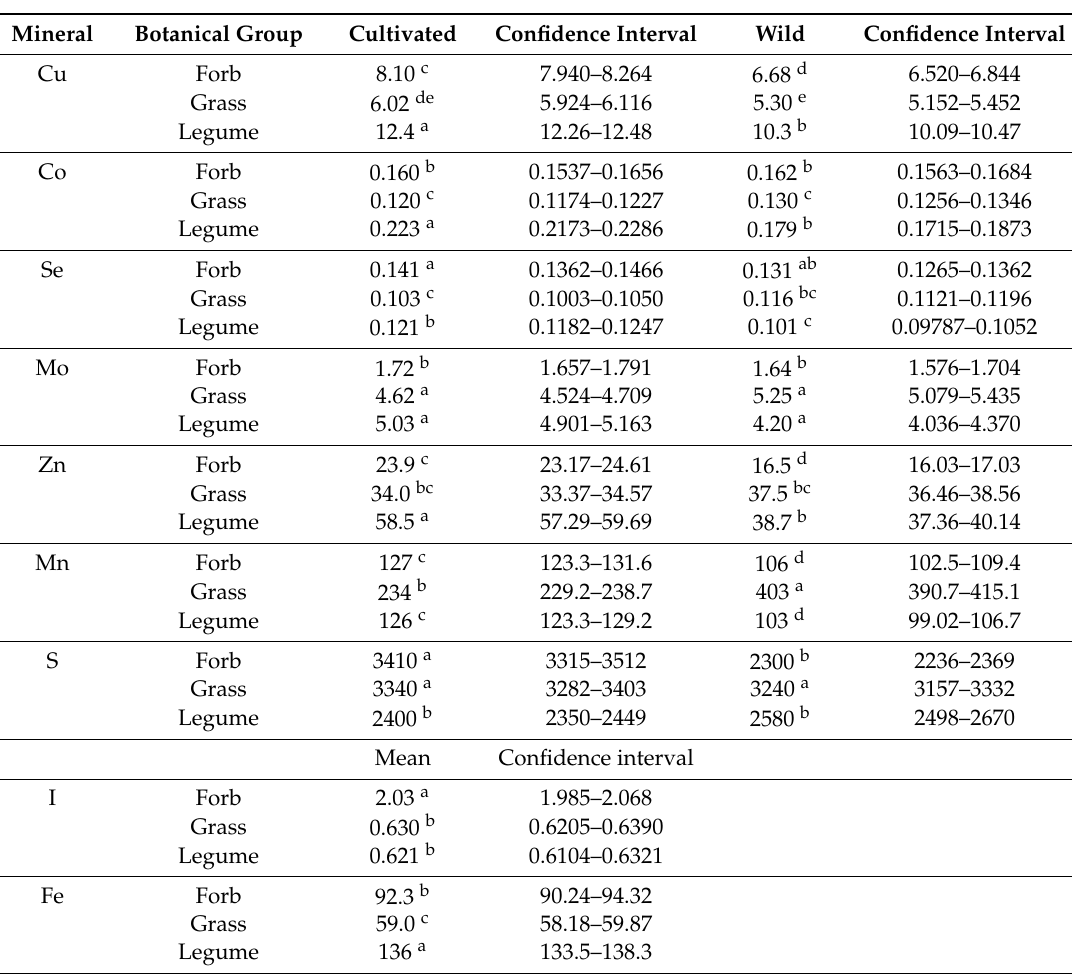
Table 3. Concentrations (mg kg − 1 DM) of minerals in plant material. Values are means and confidence intervals for the botanical groups (grass / legume / forb) across replicates and di ff erent species. Where there was a significant ( p < 0.05) interaction between botanical group and plant type (wild / cultivated), values for plant type are presented separately. Superscript letters show significant di ff erences within a